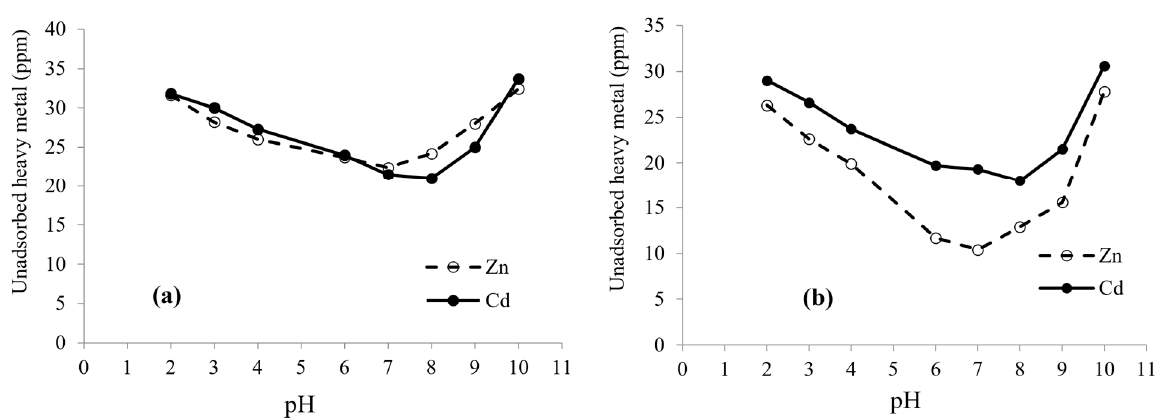
Figure 3. Effect of pH on biosorption of Zn 2+ and Cd 2+ by living ( a ) and lyophilized ( b ) biomass of Priestia megaterium PRJNA526404 .